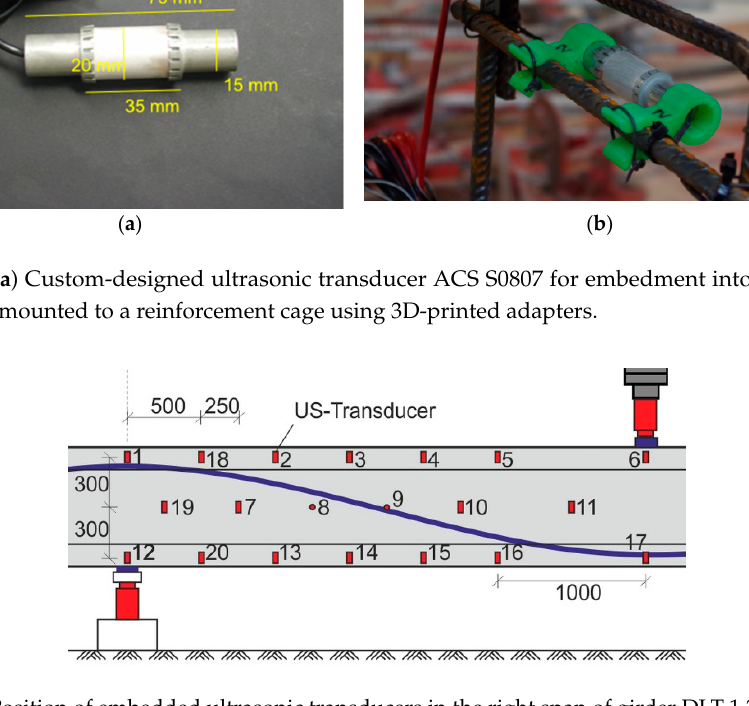
Figure 11. Position of embedded ultrasonic transducers in the right span of girder DLT 1.3 (dimensions in mm).